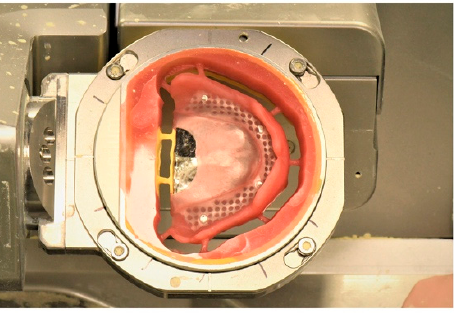
Figure 5. Fabrication of metal-reinforced complete denture extruded by 1 mm.